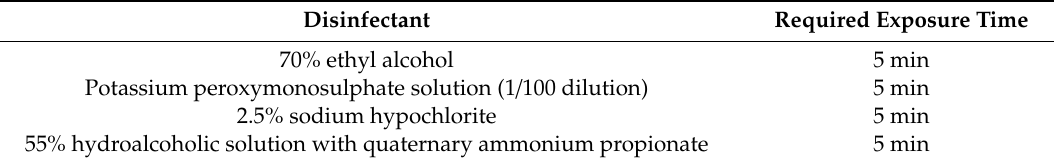
Table 3. Broad spectrum chemicals for environment